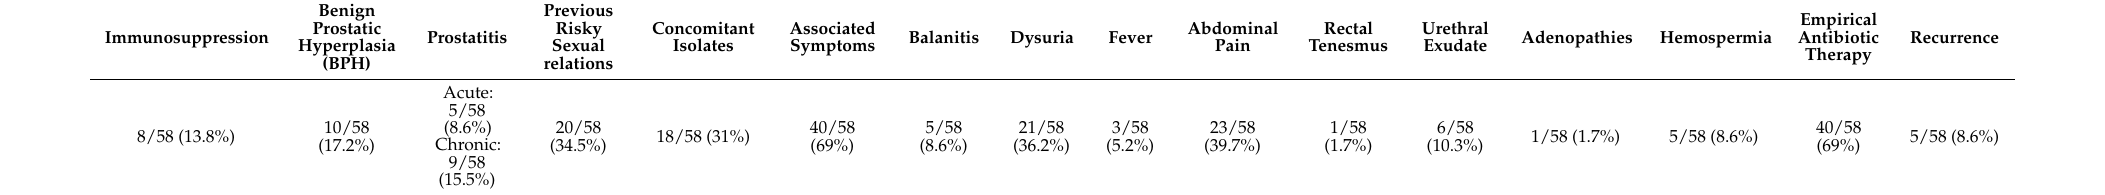
Table 2. Epidemiological and clinical variables corresponding to genital infection episodes in male